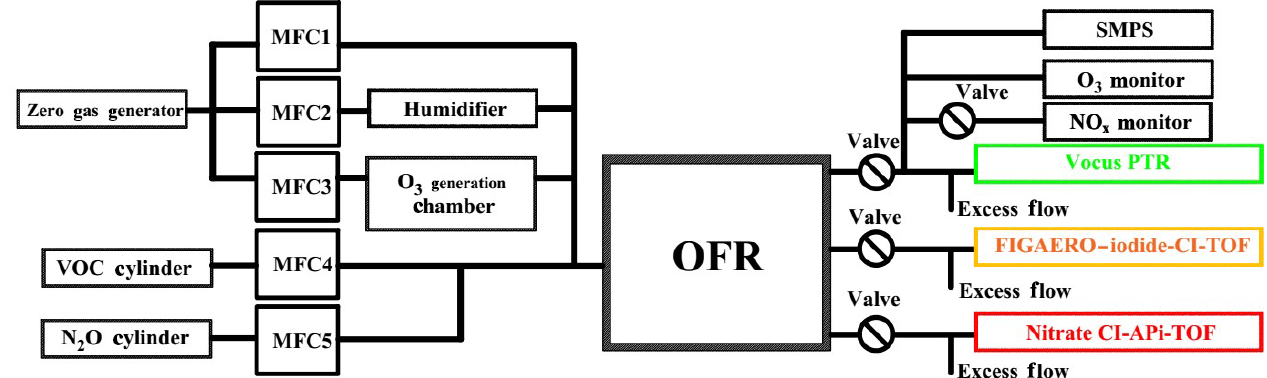
Figure 1. Schematics of experimental setup.